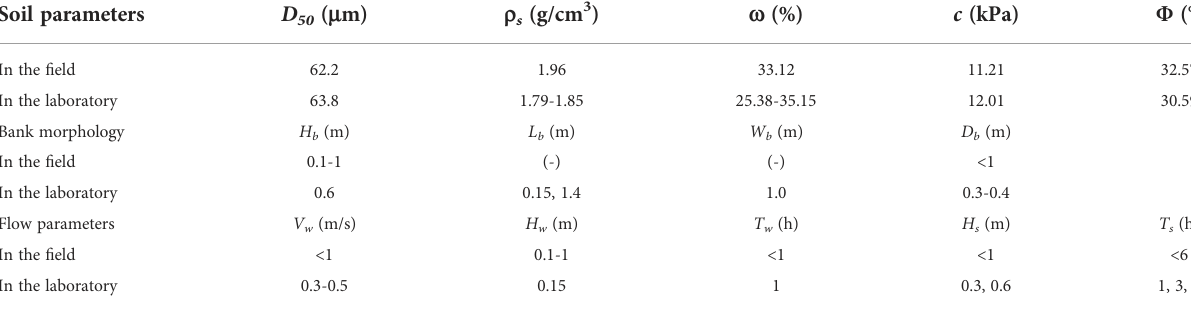
TABLE 1 Soil and fl ow parameters in fi eld observations and fl ume experiments.